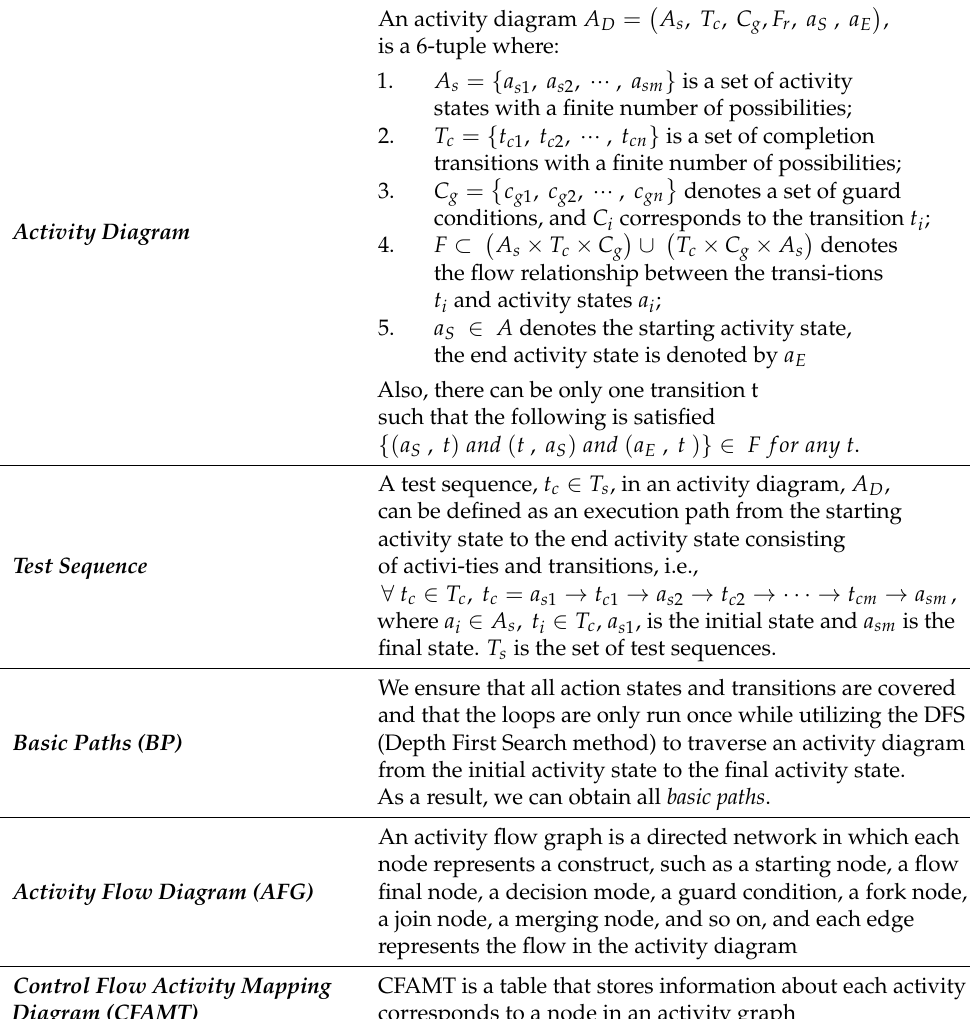
Table 1. Basic concepts and